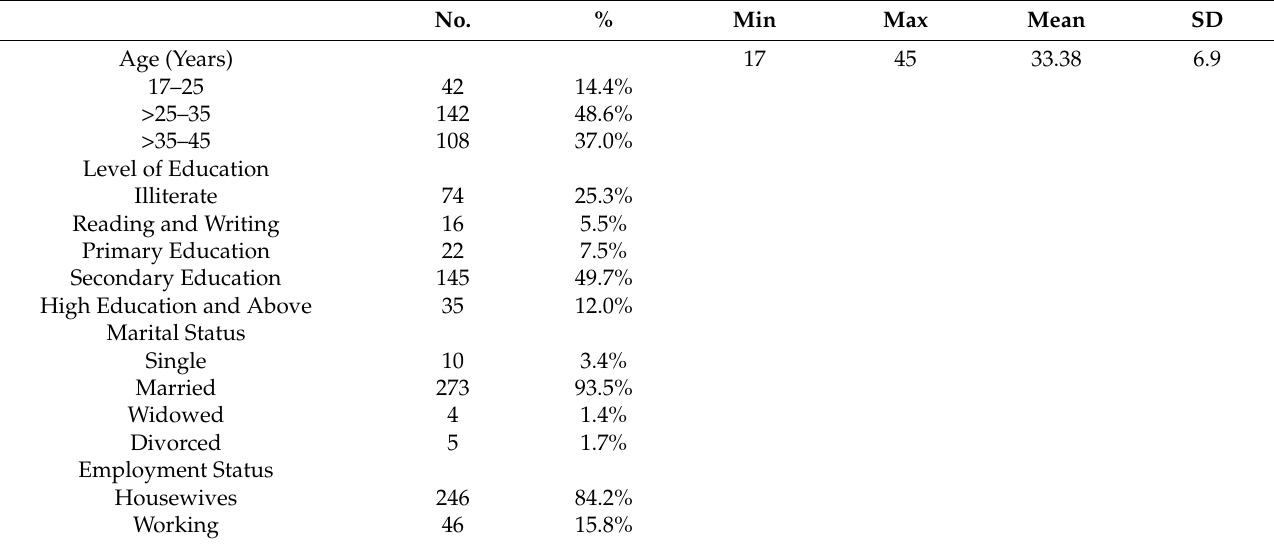
Table 1. Distribution of the subjects according to their sociodemographic